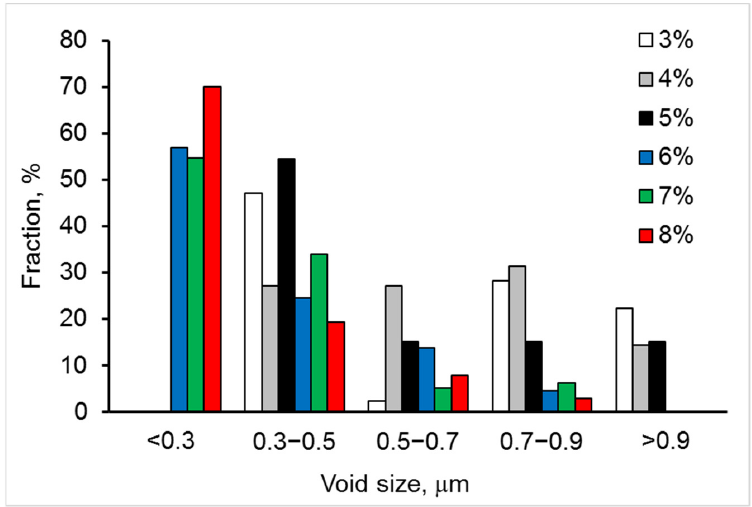
Figure 10. Size distributions of fracture voids for six studied materials with 3–8% Y 2 O 3 .